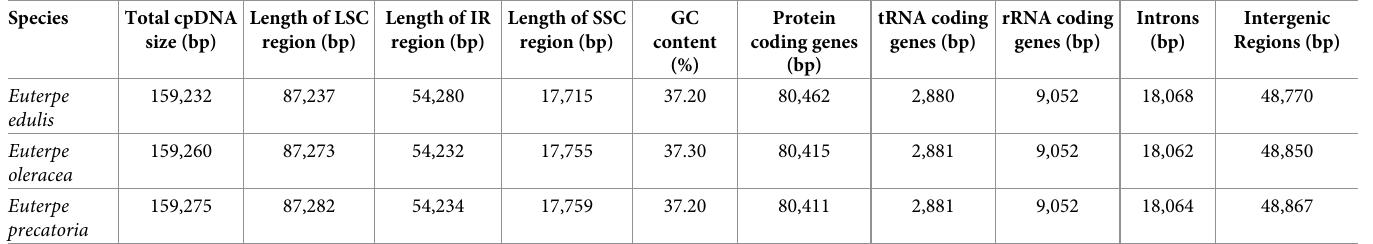
Table 1. General features of chloroplast genomes of three Euterpe species. Species Total cpDNA Length of LSC size (bp) region